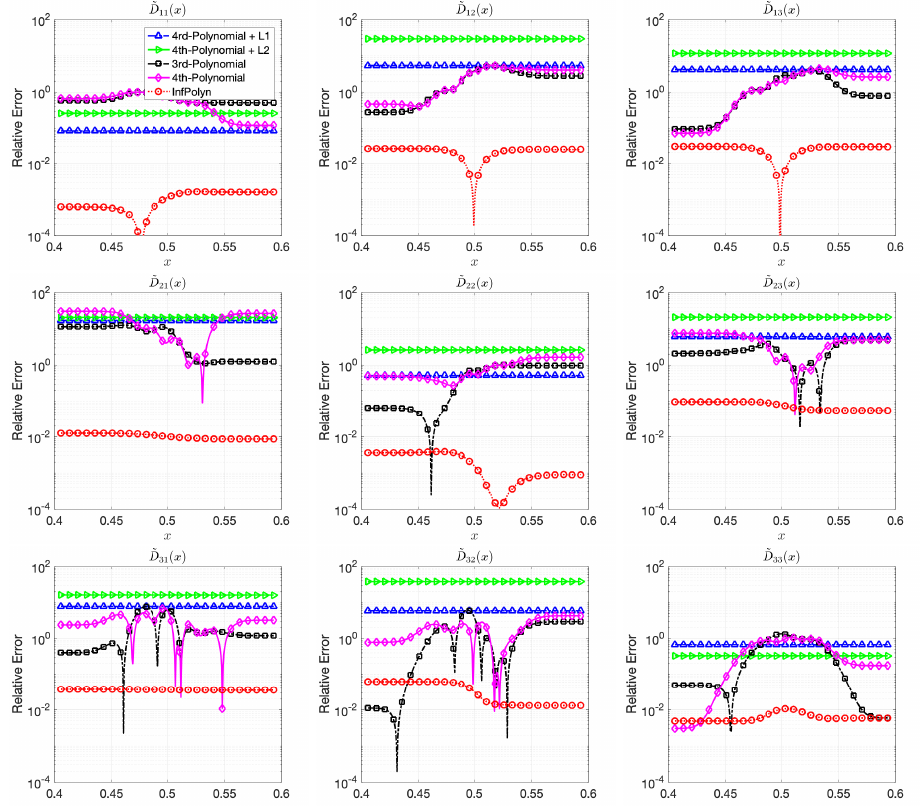
Figure 4. The relative errors (REs) of predictive diffusion coefficients ˜ D ij ( c ( x )) in the center areas x ∈ [ 0.4,0.6 ] for the evaluated methods in a quadternary